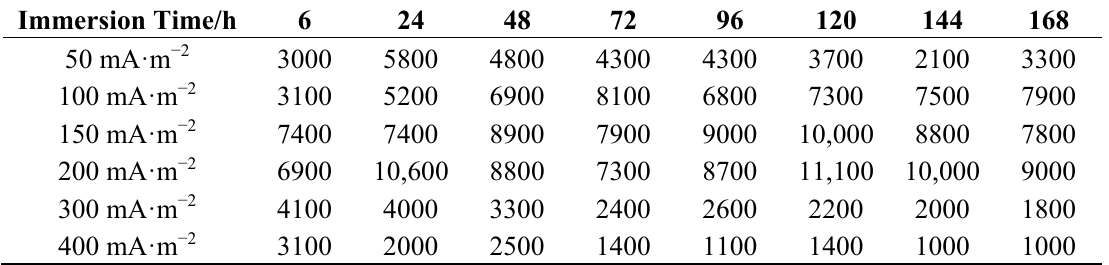
Table 3. Values of cathodic diffusion resistance W C-R / Ω ·cm 2 ·s − 0.5 with immersion time at different applied current